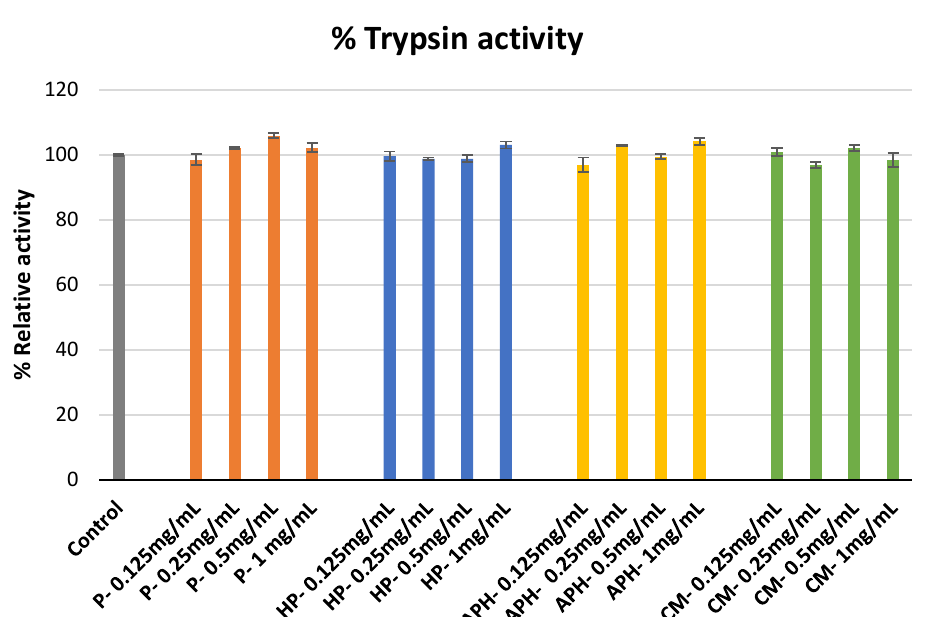
Figure 1. Modulation of trypsin catalyzed azocasein hydrolysis by P (water-soluble extract of pasteurized minced meat of BSFL), HP (water-soluble extract of hydrolyzed and pasteurized minced meat of BSFL), APH (hydrolysate of water-soluble BSFL proteins), and CM (water-soluble extract of chicken meal). Results expressed as mean ± standard deviation (n = 3).